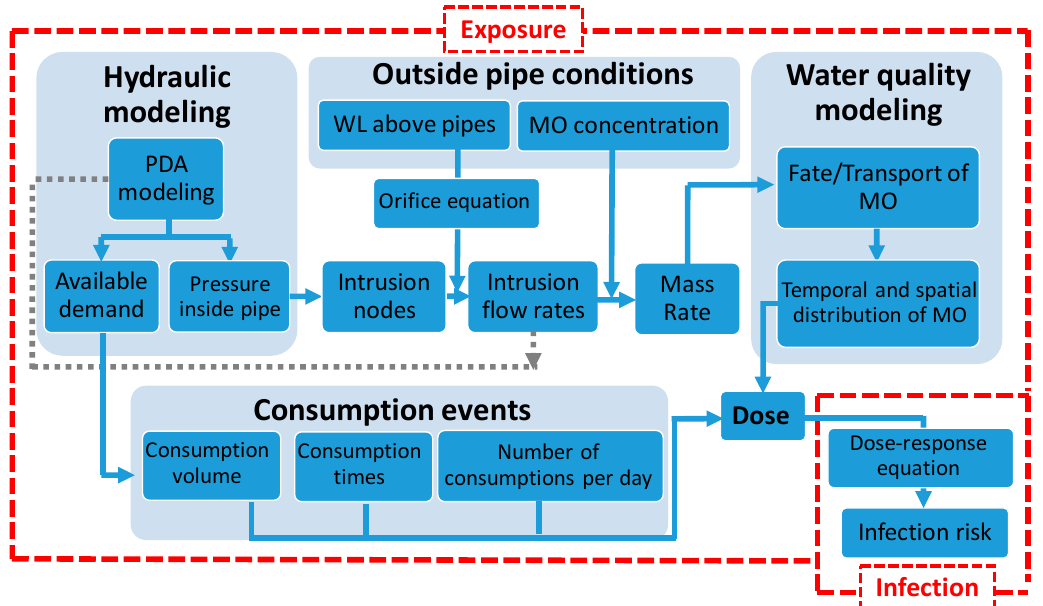
Figure 1. Flowchart for QMRA of accidental intrusion during sustained PDCs; WL, water level; MO, microorganism.